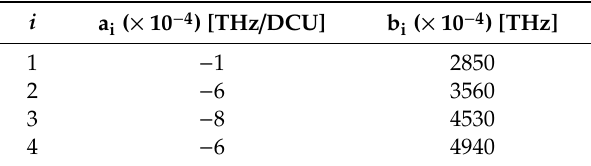
Table 1. Fitting parameters used in Equation (2) according to the resonance index i . DCU stands for dielectric constant unit.